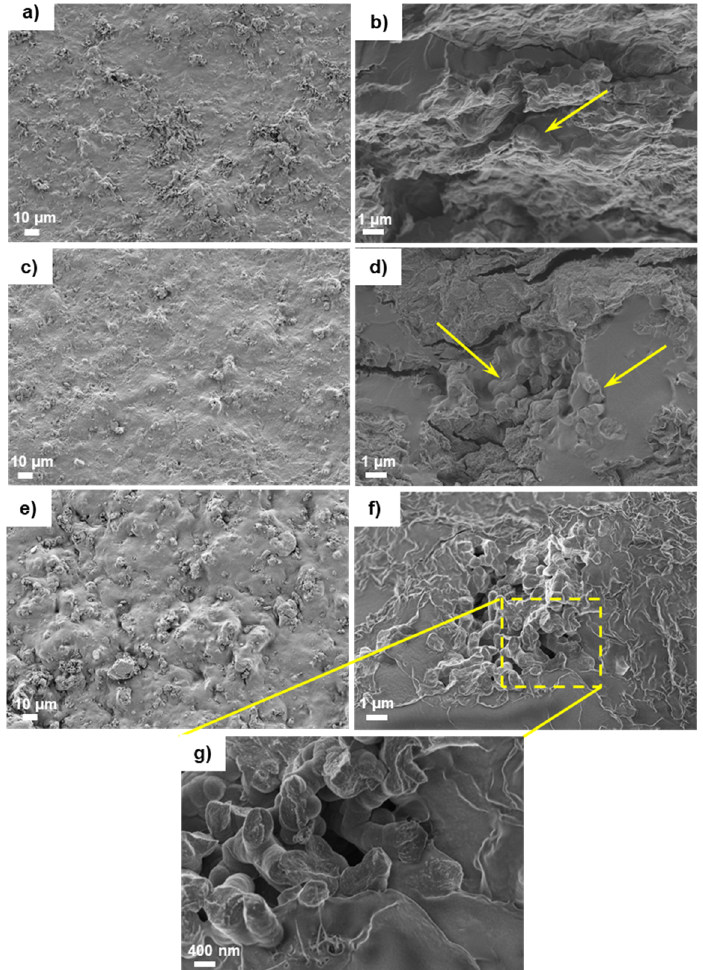
Figure 2. HR-FESEM photomicrographs of surface and impact fracture of semi-IPN PHBV/PVA with different percentage of PPy nanoparticles: ( a ) Surface of PHBV/PVA E2 composite; ( b ) Cross-section of PHBV/PVA E2 composite; ( c ) Surface of PHBV/PVA E10 composite; ( d ) Cross-section of PHBV/PVA E10 composite; ( e ) Surface of PHBV/PVA E15 composite; ( f ) Cross-section of PHBV/PVA E15 composite; ( g ) PPy nanoparticles embedded within the PHBV/PVA E15 composite in the cross-section at higher magnification. Arrows in ( b ) and ( d ) indicate PPy nanoparticles embedded in the matrix.